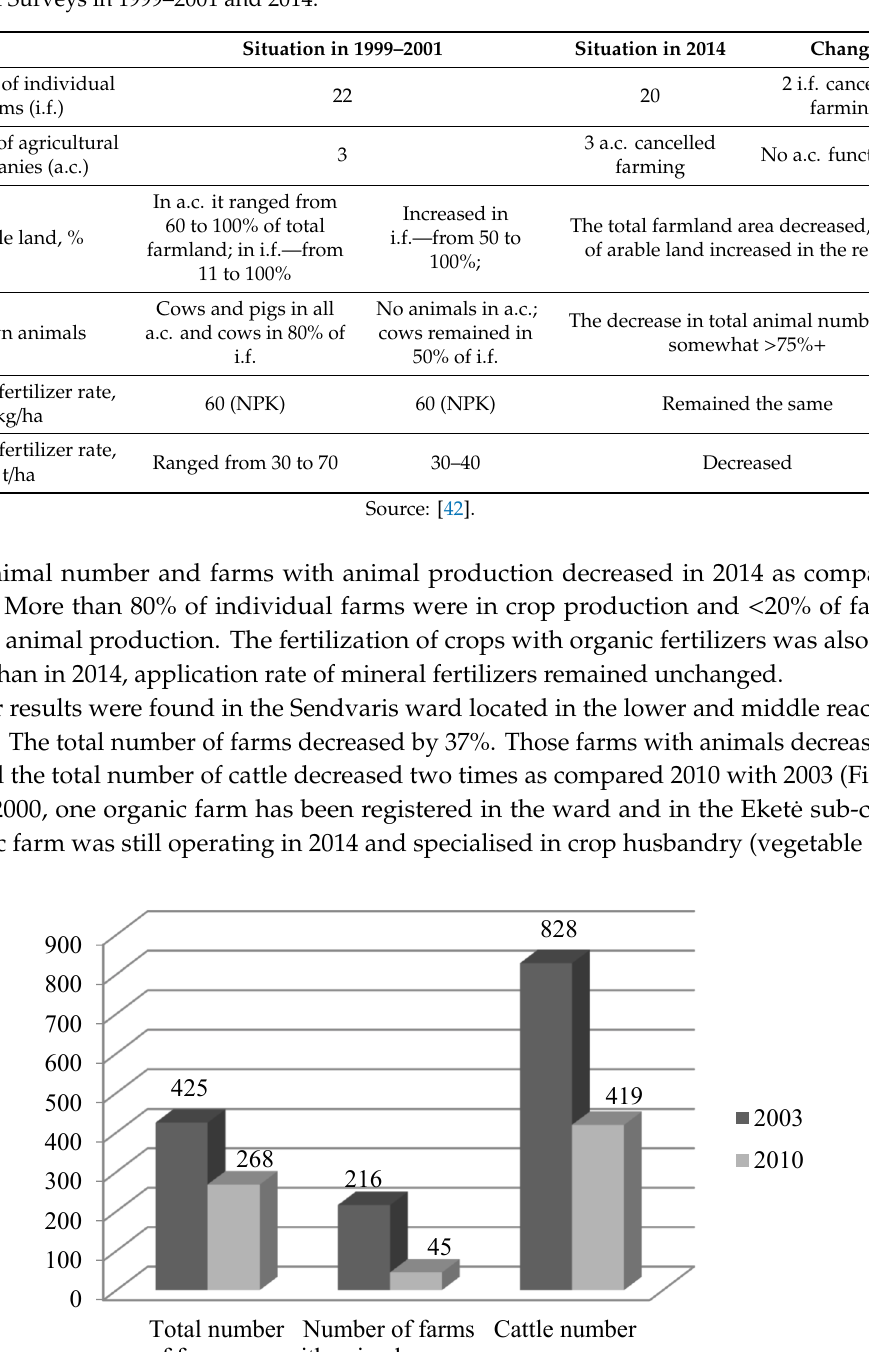
Table 4. Farms and farming intensity in the Eket ė sub-catchment according to the summarised results of Farm Surveys in 1999–2001 and 2014.